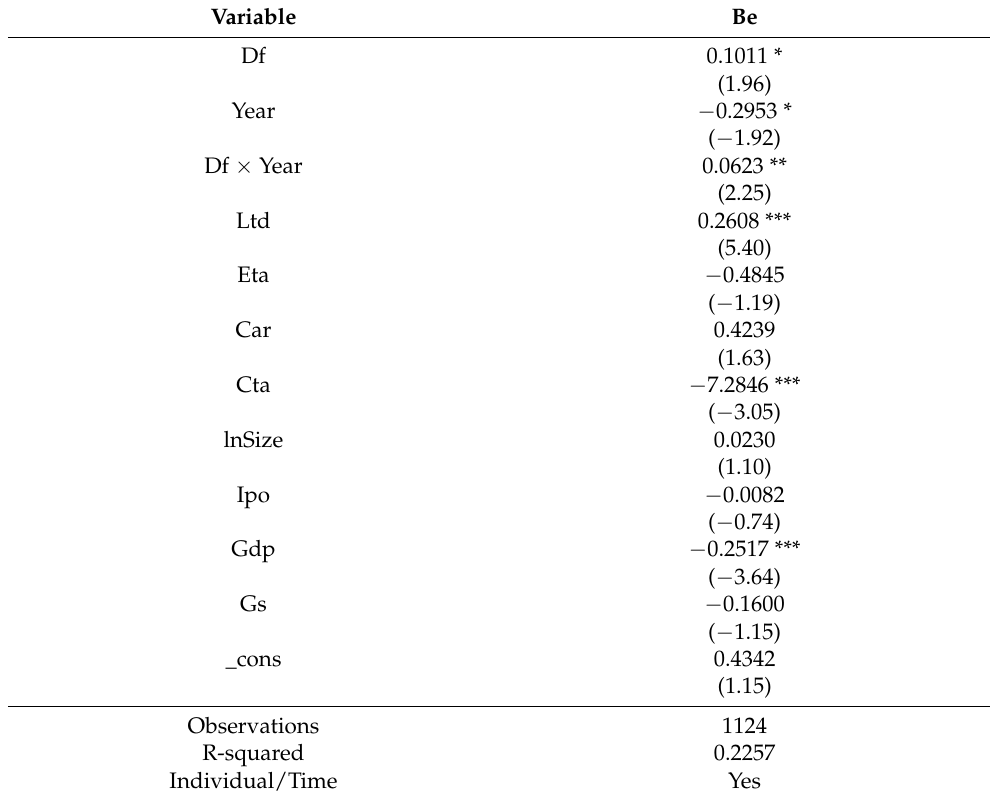
Table 8. The test for heterogeneity.